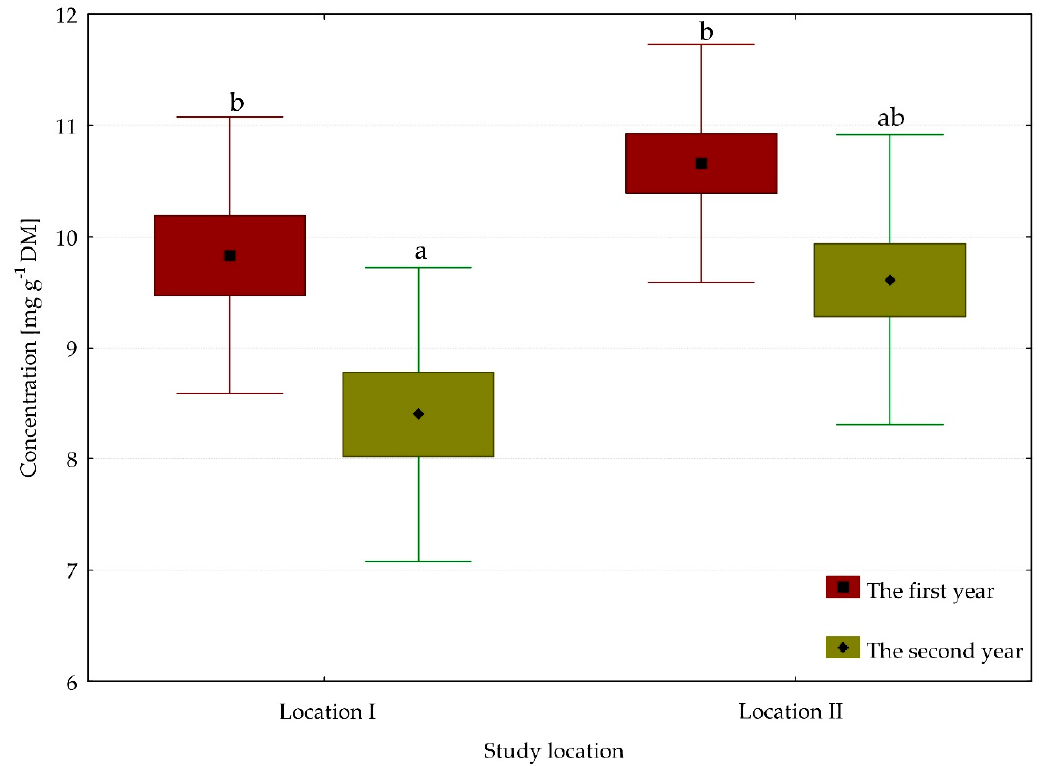
Figure 3. Chlorophyll ( a + b ) content in Melica nutans leaf blades from two natural forest stands.